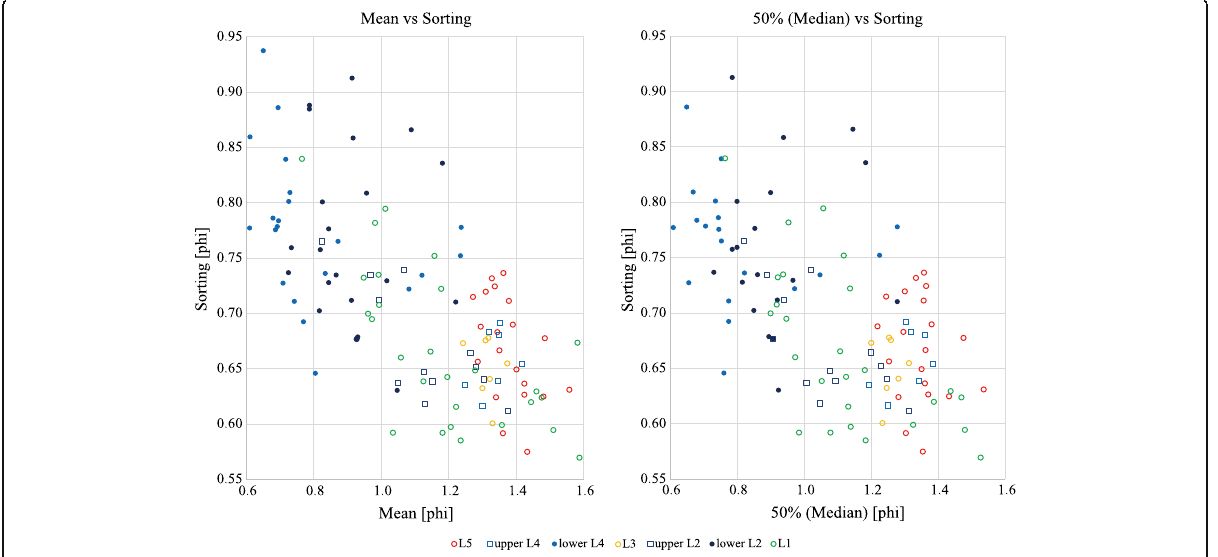
Fig. 7 Statistical values of grain size: a , mean grain size versus sorting; b , median grain size versus